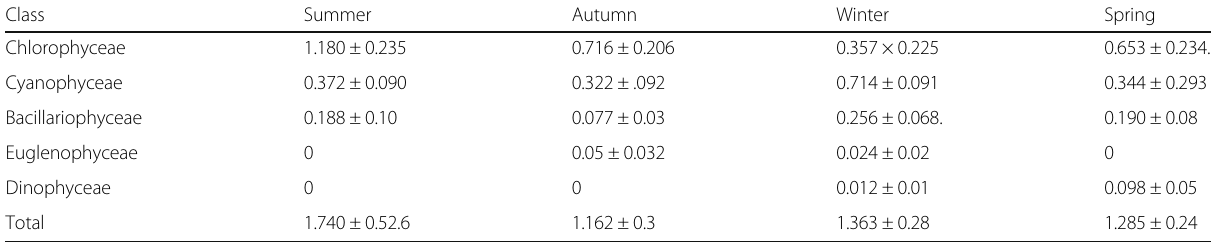
Class Summer Autumn Winter